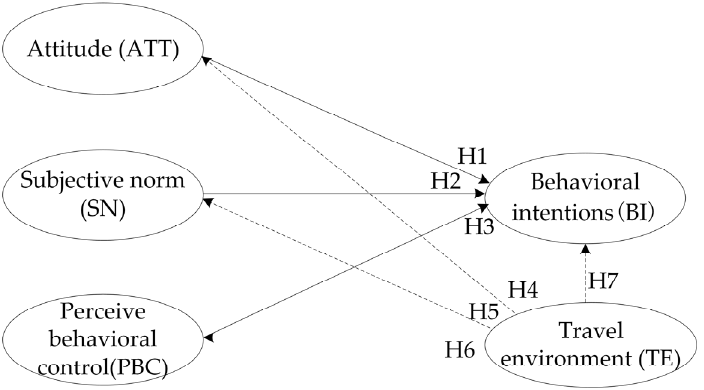
Figure 2. Structural model.